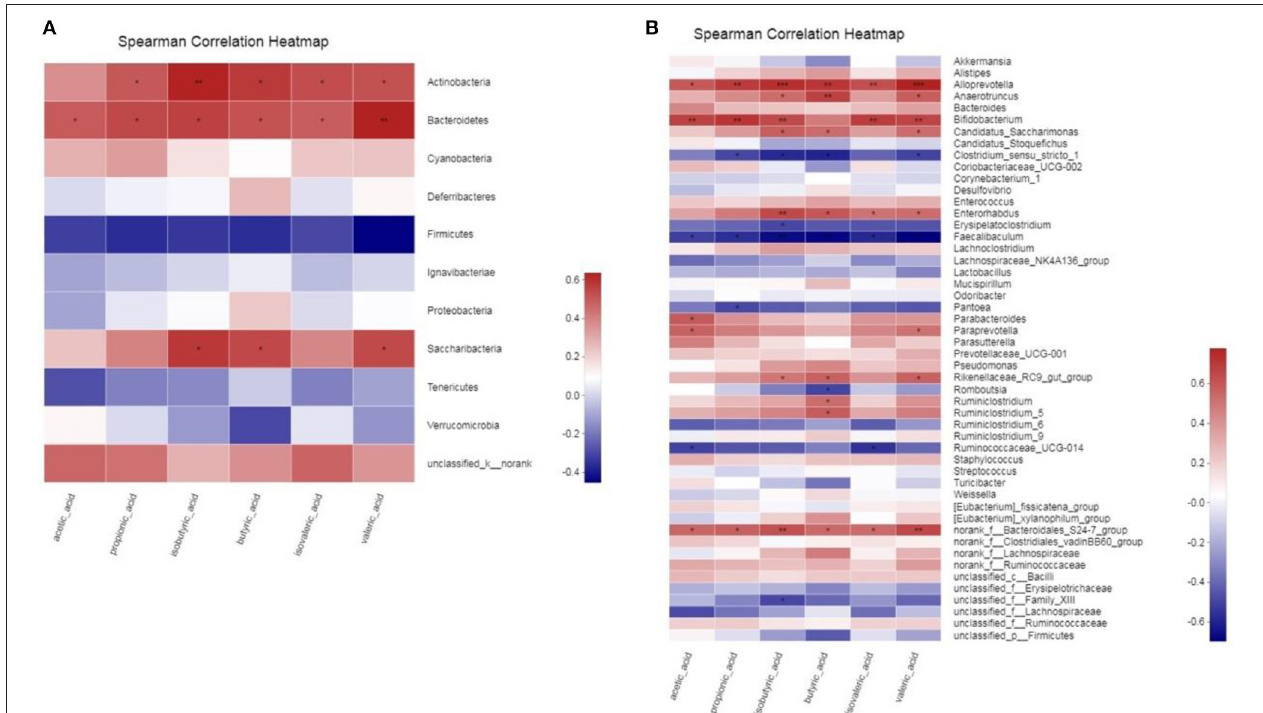
FIGURE 10 | (A,B) Correlation between gut microbiota and SCFAs parameters. * 0.01 < p ≤ 0.05, ** 0.001 < p ≤ 0.01, *** p ≤ 0.001.